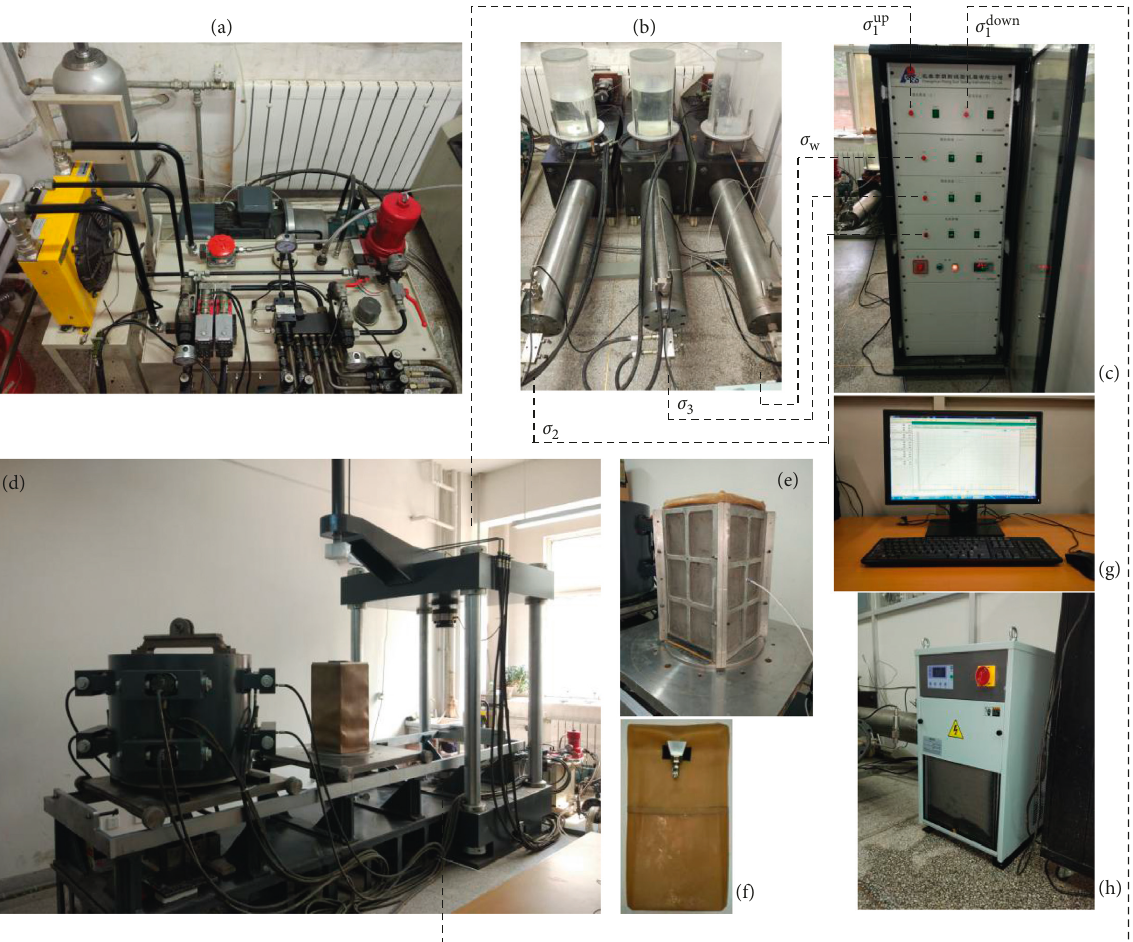
Figure 6: Physical map of a large-scale true triaxial apparatus: (a) oil source system, (b) hydraulic drive system, (c) control cabinet, (d) true triaxial mainframe, (e) specimen mold, (f) 4 flexible hydraulic rubber bags, (g) program-controlled operating interface, and (h) oil cooling system.